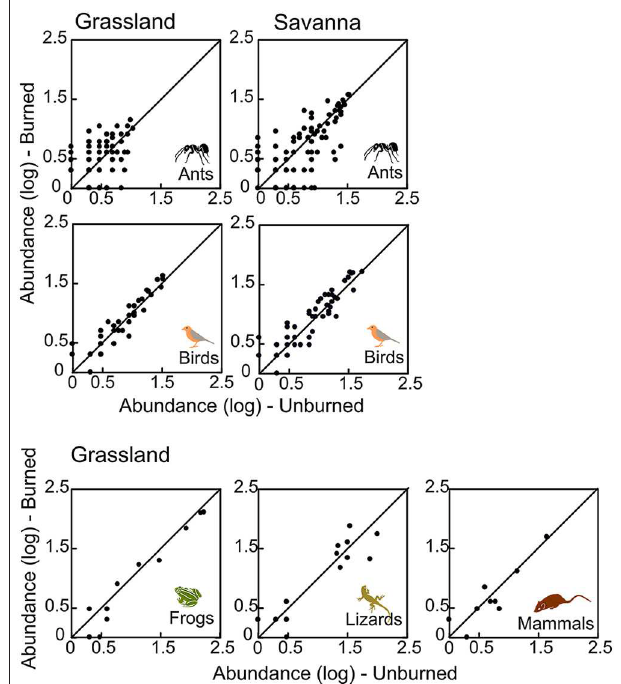
FIGURE 5 | Abundance (log 10 -transformed data) of different animal groups sampled in unburned and burned areas of grassland and savanna. Each point represents one species. The line represents the 1:1 equivalence line, at Santa Bárbara Ecological Station, state of São Paulo,